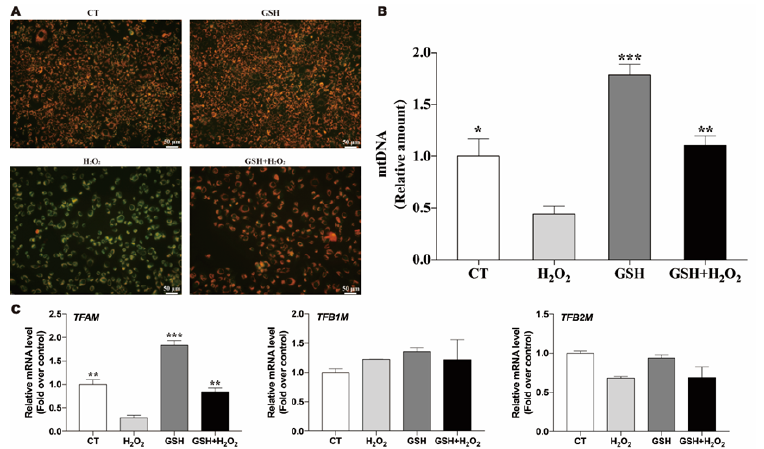
Figure 3. GSH rescues the H 2 O 2 -impaired mitochondrial function. Cells were pretreated with or without H 2 O 2 (500 µ M) for 24 h. Afterwards, the culture medium was removed replaced with fresh medium with or without GSH (1.6 mM) and incubated for another 24 h. ( A ) MMP was determined by measuring the fluorescence intensity of JC-1 monomers and aggregates. ( B ) The mitochondrial copy number was determined to investigate the mitochondrial biogenesis. Data are presented as the mean ± SEM of three independent experiments. * p < 0.05 compared with the H 2 O 2 -exposed IPEC-J2. ( C ) Effects of exogenous GSH on the expression of mitochondrial transcription factors. ** p < 0.01 compared with the H 2 O 2 -exposed IPEC-J2. *** p < 0.001 compared with the H 2 O 2 -exposed IPEC-J2.